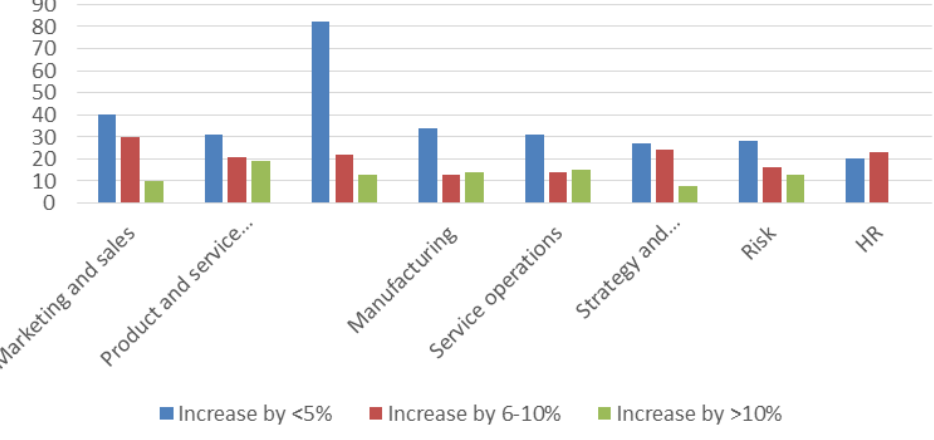
Figure 1. Average increase in revenue [9]